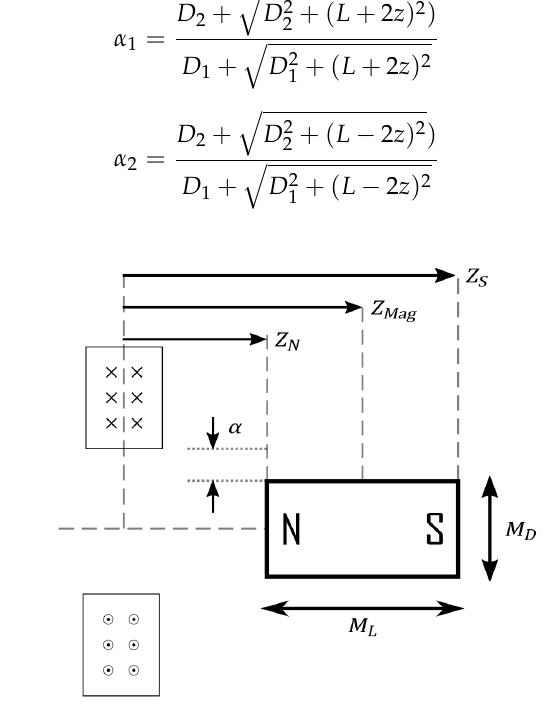
Figure 3. Schematic diagram of the actuator used to show the dimensions of the